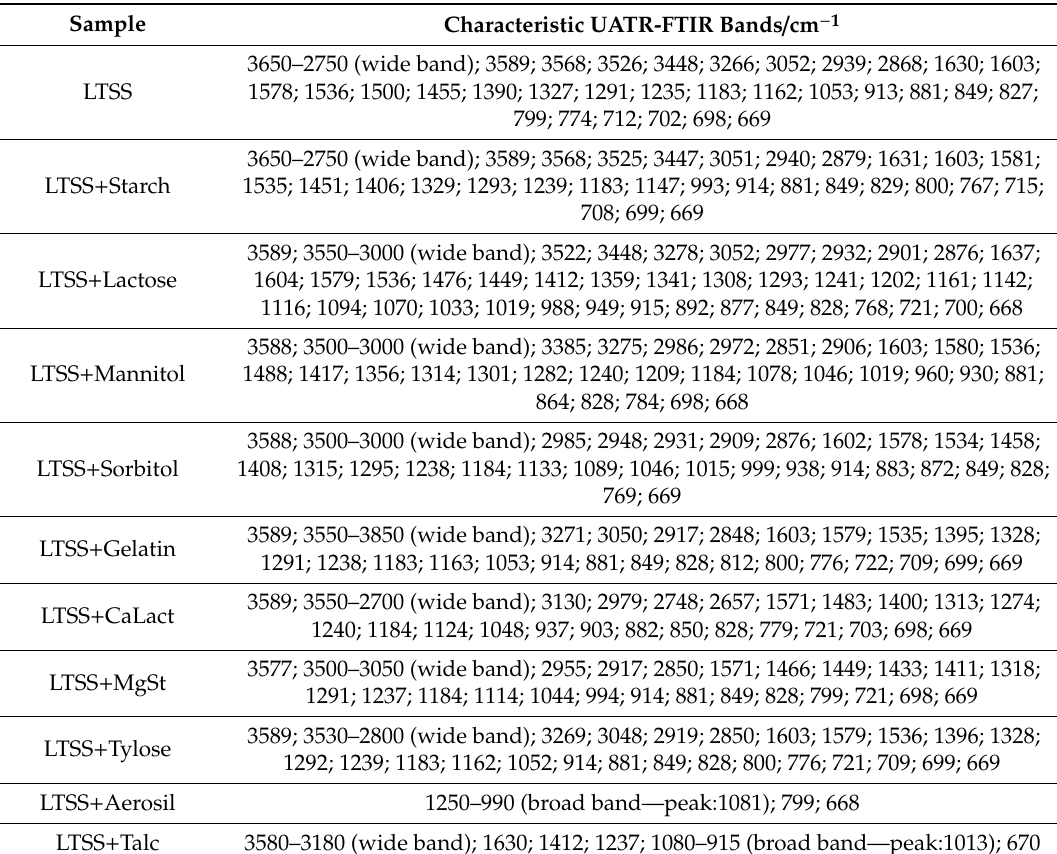
Table 1. Universal attenuated total reflectance-Fourier transform infrared spectroscopy) (UATR-FTIR) spectral bands obtained for LTSS and each binary